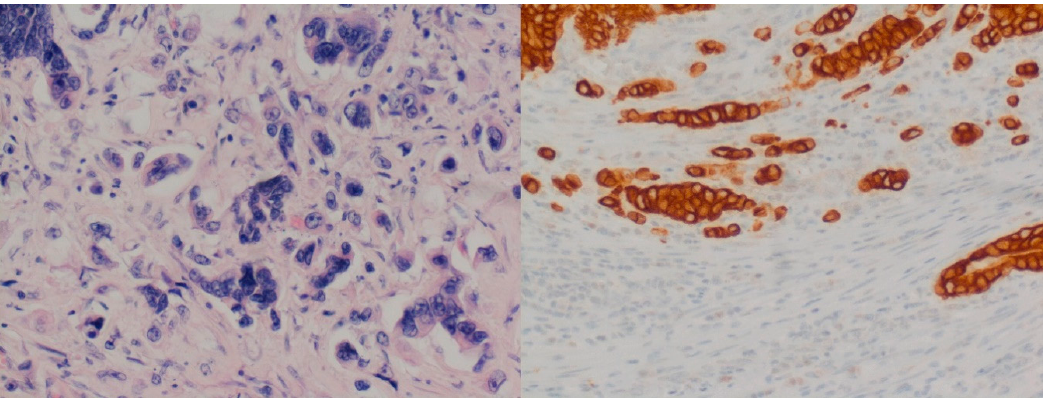
× , H & E and cytokeratin